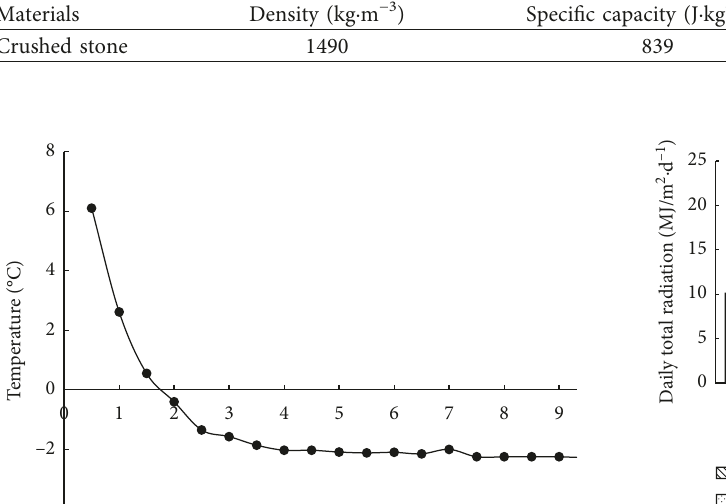
Table 5: Thermal parameters for crushed stone layer.